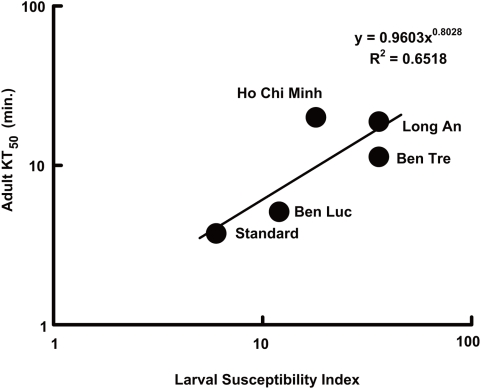
Correlation between the larval susceptibility index and the adult KT50 of Ae. aegypti collected from several places in Vietnam.Each plot indicates the location from where a mosquito colony was collected. The adult KT50 was calculated by the knockdown test by burning 0.5 g of mosquito coil containing 0.3% (w/w) d-T80-allethrin in a glass chamber (70×70×70 cm).